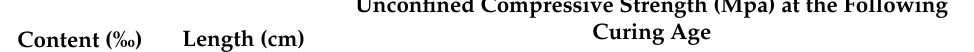
Table 5. Experiment results of unconfined compressive strength.